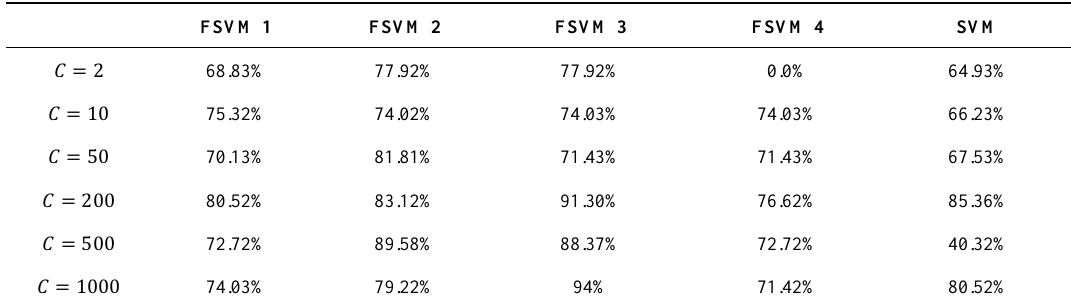
Figure 1. FSVM and SVM accuracy results Table 2. Classification accuracy results